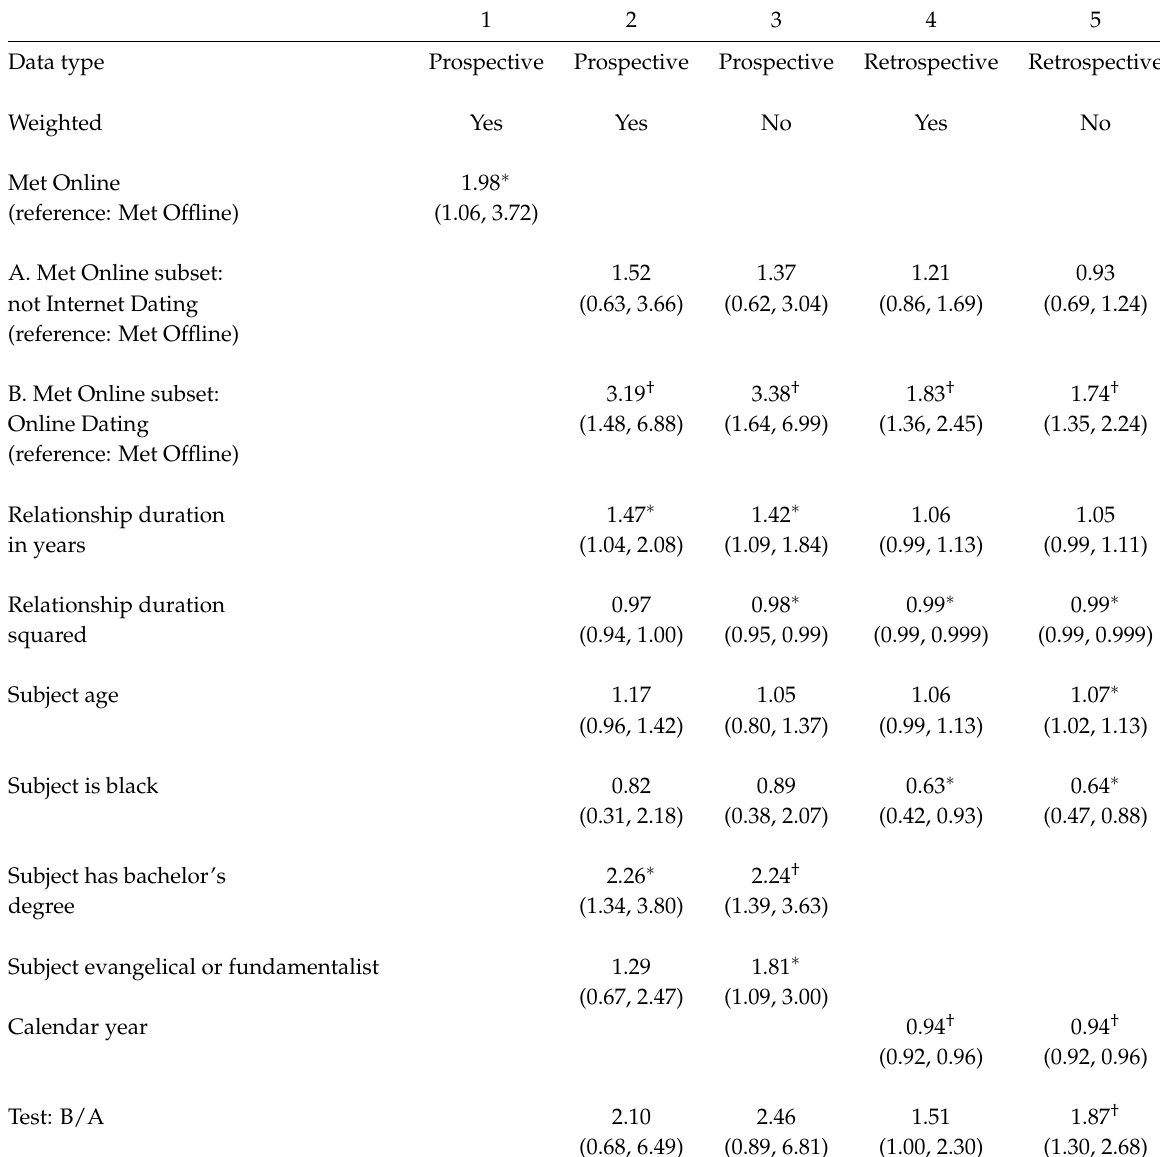
Table 3: Predicting transitions to marriage for heterosexual couples: odds ratios (and 95% CI) from event history logistic